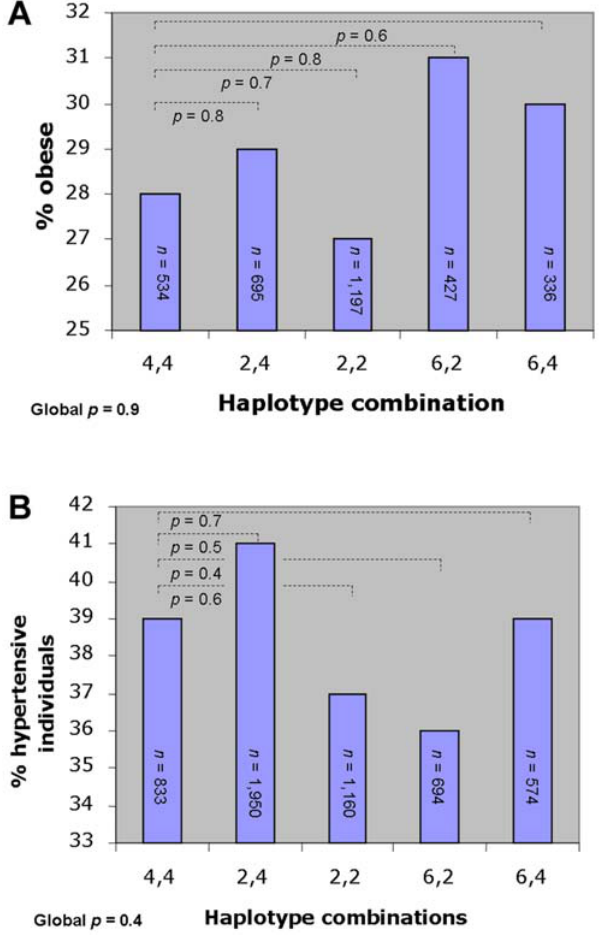
Figure 1. Case-control study comparing the frequency of obese and hypertensive individuals among the ADRB2 haplotype pairs, respectively. A: The proportion of obese out of the combined number of individuals in the lean group (BMI , 25 kg/m 2 ) and the obese (BMI . 30 kg/m 2 ) group ( n =3,189). B: The proportion of hypertensive individuals out of the combined number of individuals in the normotensive group and the hypertensive group ( n =5,211).